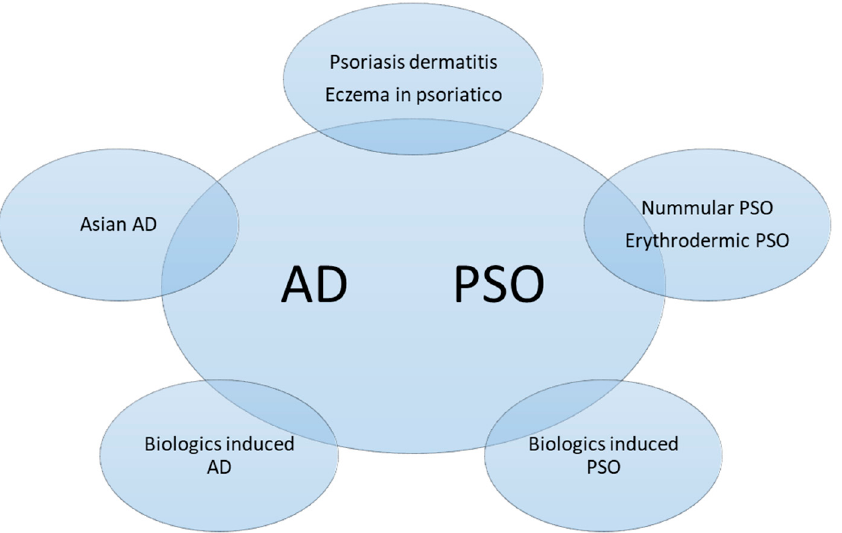
Figure 4. Subtypes of overlapping psoriasis (PSO) and atopic dermatitis (AD). The phenotypes could be classified into concomitant PSO and AD, mainly PSO lesions with AD features or vice versa, or disease transformation as a result of biologics treatment.